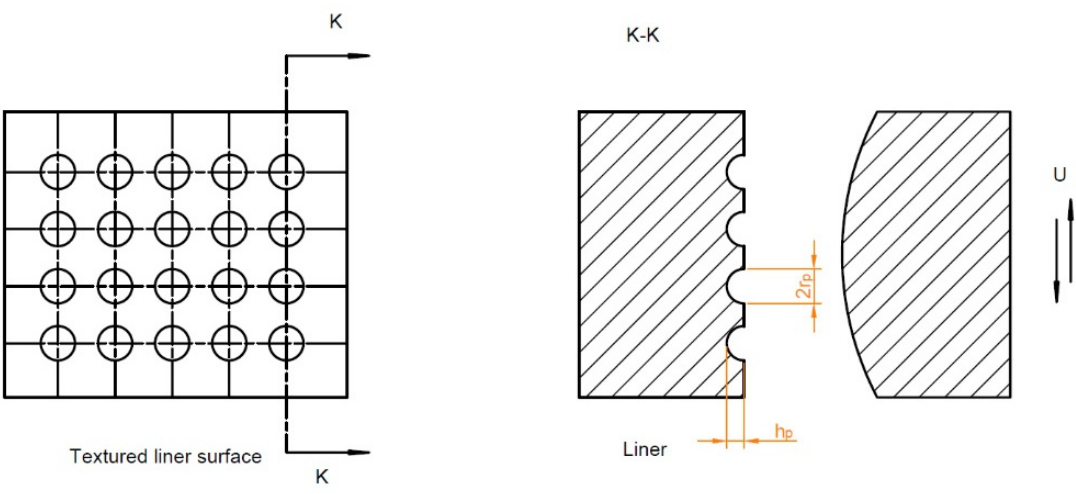
Figure 23. Schematic diagram of the geometry of dimples on the cylinder liner surface, after [134].